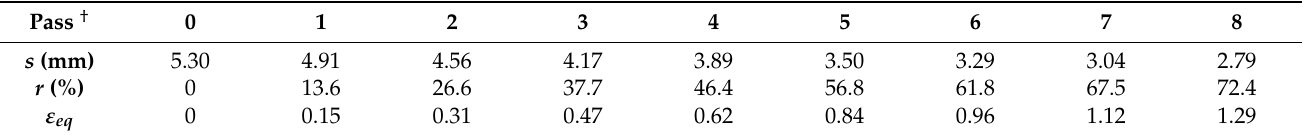
Table 1. ε eq and shape factors for its calculation for each deformation pass of MPCR